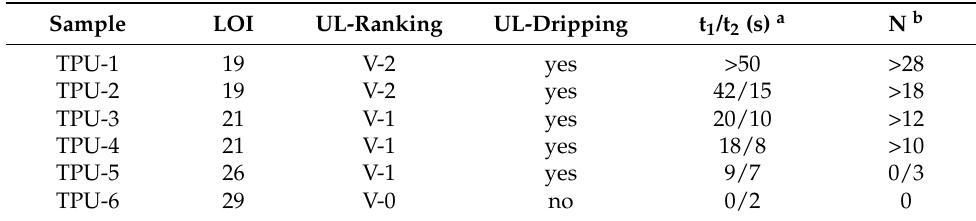
Table 3. Flame retardant performance of